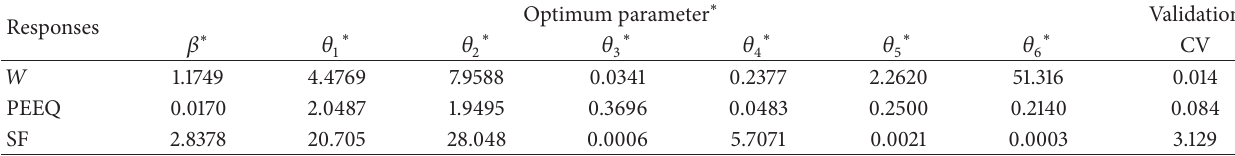
Table 5: Optimum parameter and validation of kriging